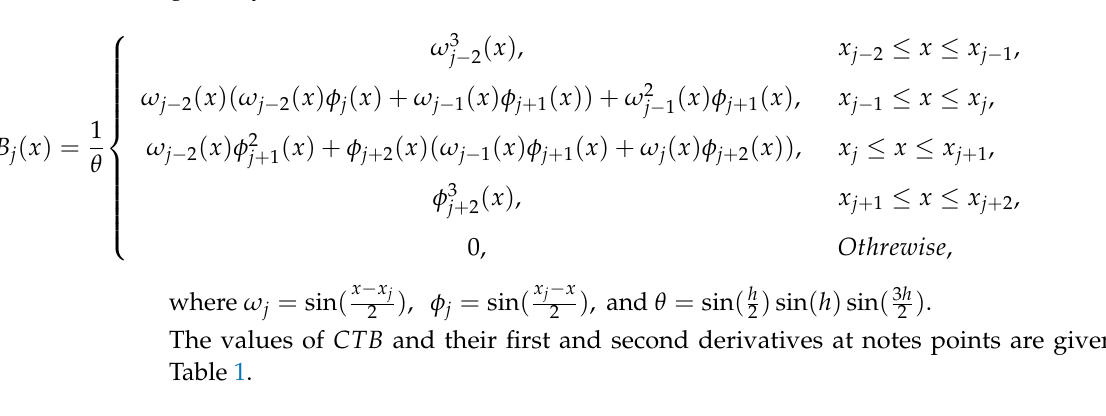
Table 1. CTB and their first and second